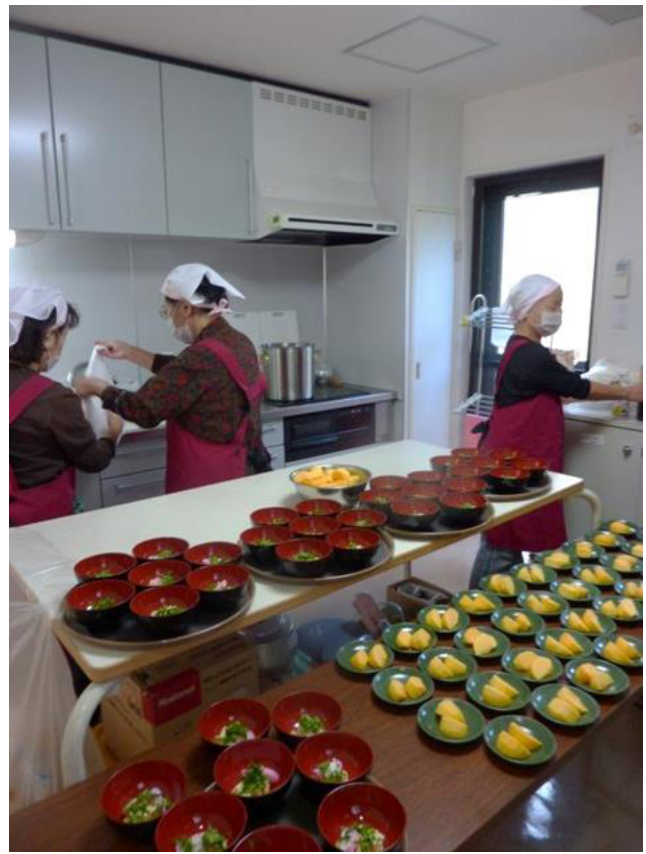
Figure 1. Preparations for the food service for the elderly—doing things “properly.” Photo by